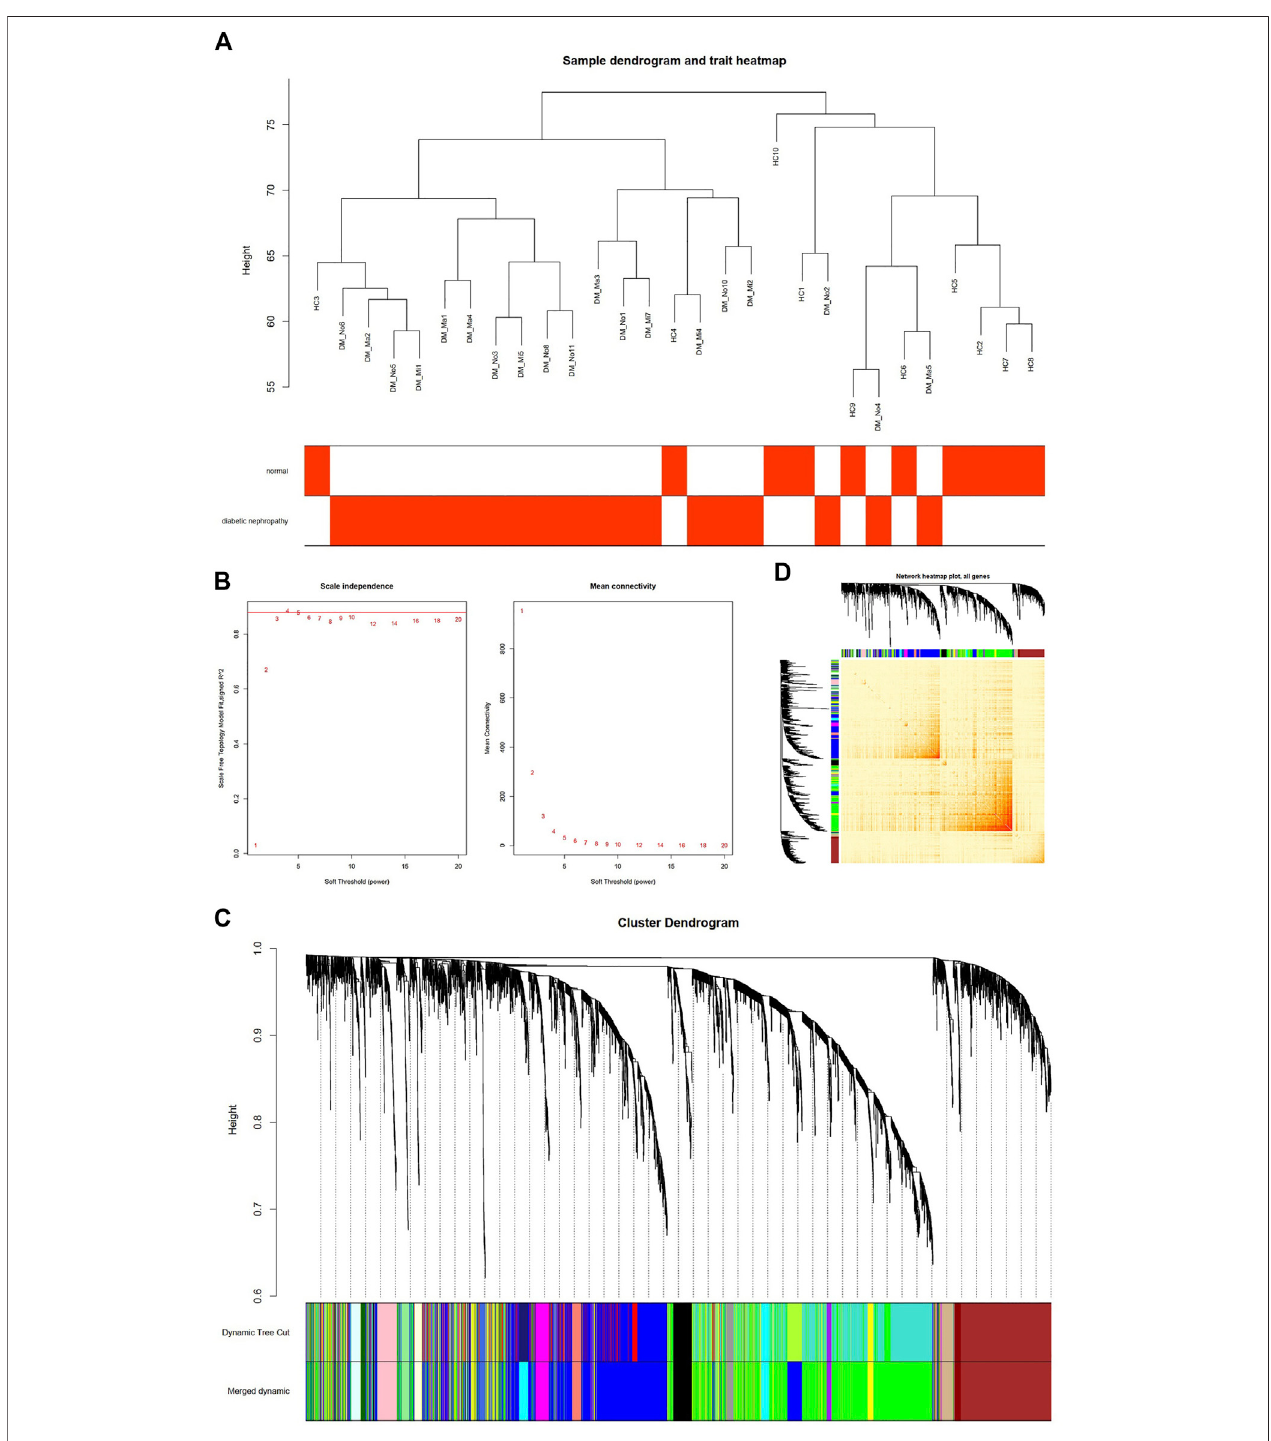
FIGURE 2 | Construction of Co-Expression Network in GSE142153 by WGCNA. (A) Sample dendrogram and trait heatmap. (B) Scale independence (Left) and Mean connectivity (Right) . (C) The Cluster dendrogram of co-expression network modules is ordered by a hierarchical clustering of genes based on the 1-TOM matrix. Different colors represent different modules. (D) Network heatmap plot in the co-expression modules (The progressively saturated red colors indicated higher overlap among the functional modules.).